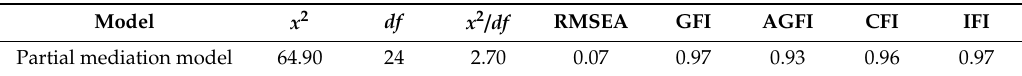
Table 3. Results of fit indices for the partial mediation